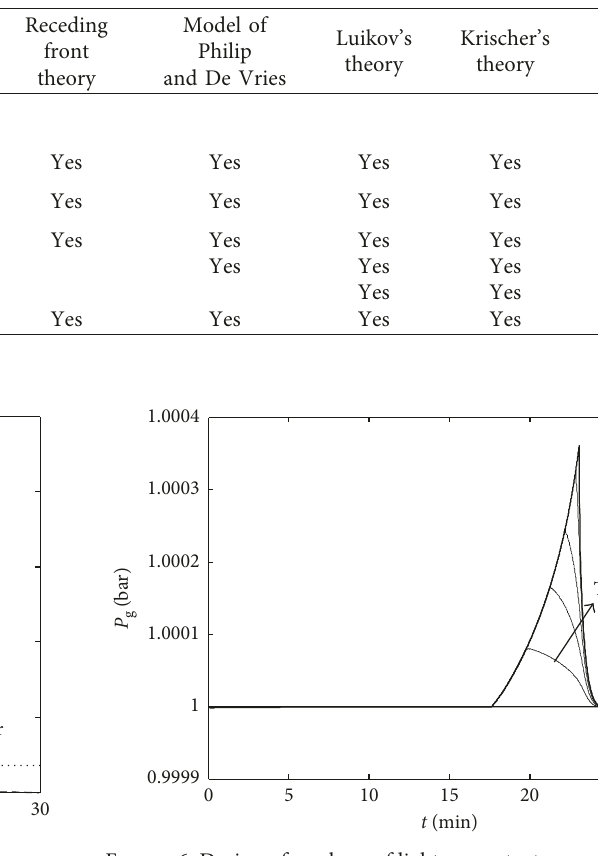
Table 1: Comparison of different drying models.